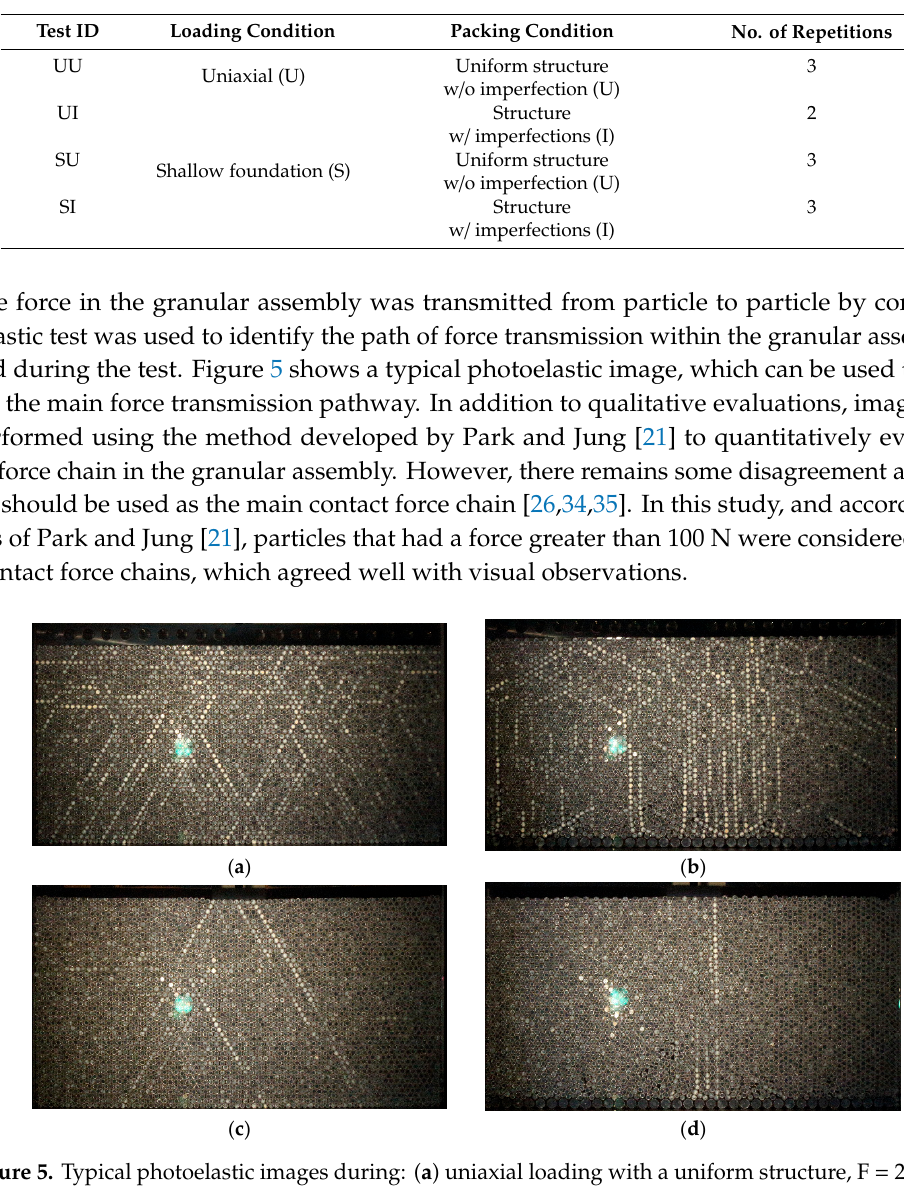
Table 1. Test loading and packing (structural) conditions.